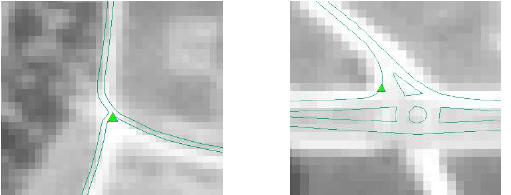
Figure 2. Examples of 3D reference points (GCPs) selected from road intersections in the original RASAT orthoimages (contrast enhancement is applied for display